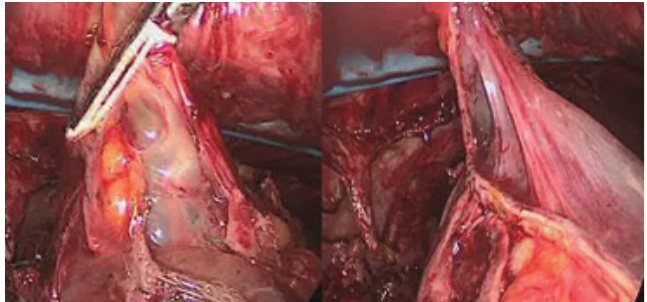
Figure 4 - Operation